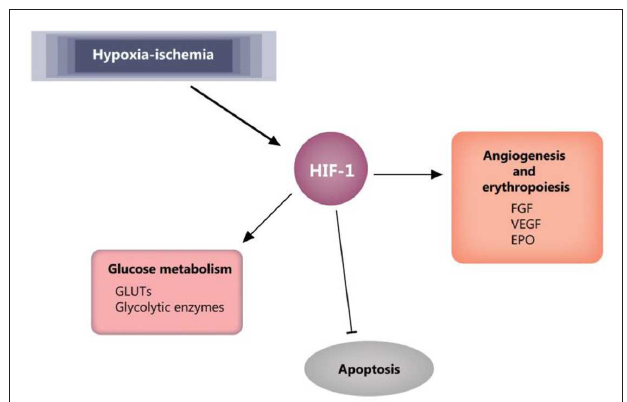
FIGURE 5 | HIF-1 effects in ischemia. Blunt arrow indicate inhibition, pointed arrows indicate stimulation. EPO, erythropoietin; FGF, fibroblast growth factor; GLUTs, glucose transporters; HIF-1, hypoxia-inducible factor 1; VEGF, vascular endothelial growth